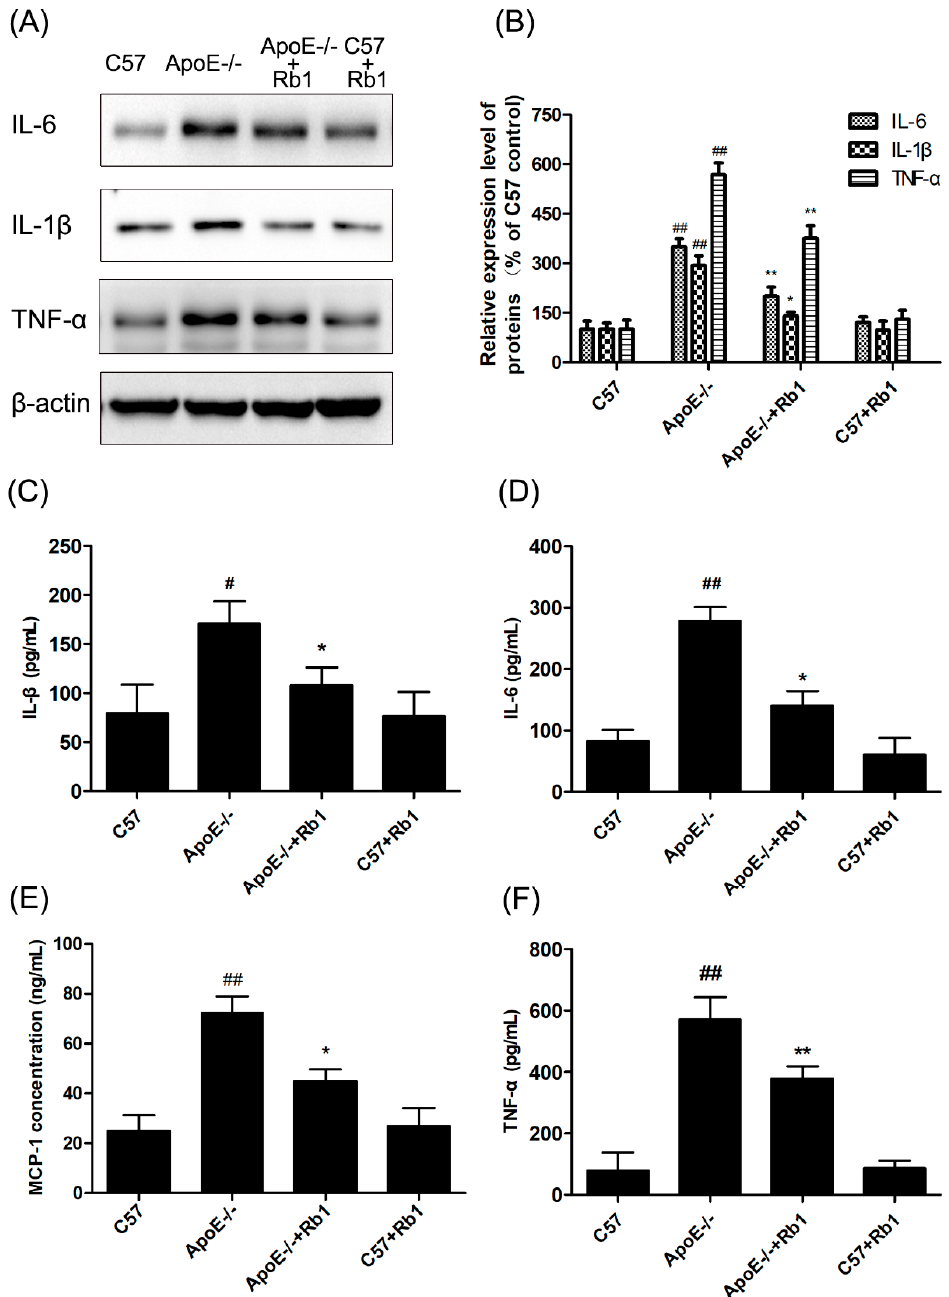
Figure 4. Rb1 suppressed inflammatory cytokines in the serum of ApoE-/- mice. ( A ) Levels of IL-1 β , IL-6 and TNF- α as measured by western blot analysis. ( B ) Quantitative analysis was performed on the corresponding bands. ( C ) Effect of Rb1 on IL-1β levels as measured by ELISA. ( D ) Effect of Rb1 on IL-6 levels as measured by ELISA. ( E ) Effect of Rb1 on TNF- α levels as measured by ELISA. ( F ) Effect of Rb1 on TNF- α levels as measured by ELISA. The data are expressed as the mean ± the standard error (SE) of the mean in each group ( n = 3). ## p < 0.01, # p < 0.05 vs. C57 control; * p < 0.05, ** p < 0.01 vs. ApoE-/- model.